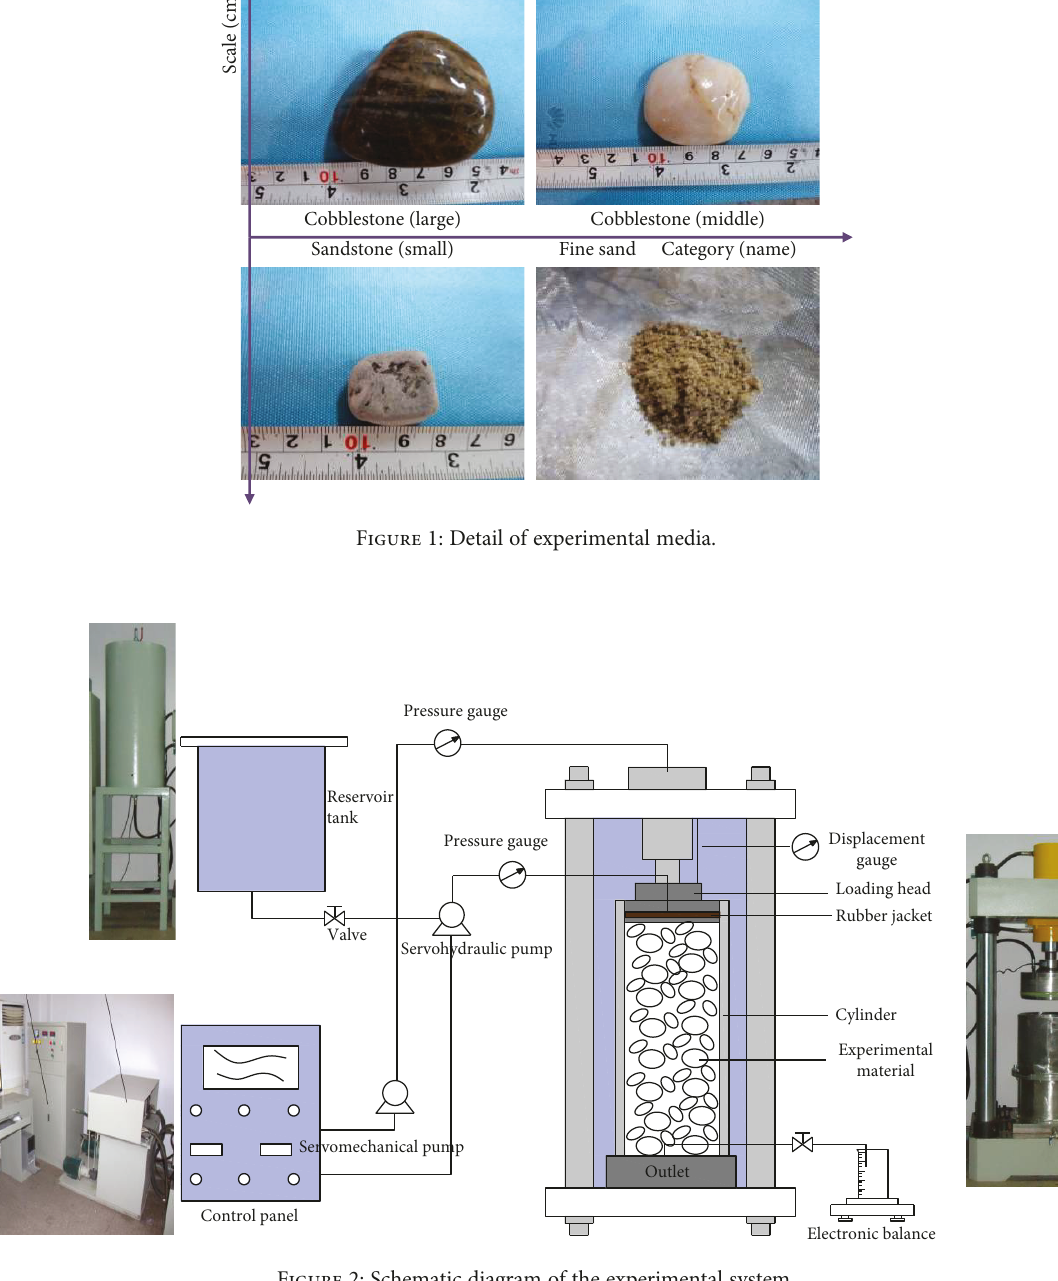
Figure 2: Schematic diagram of the experimental